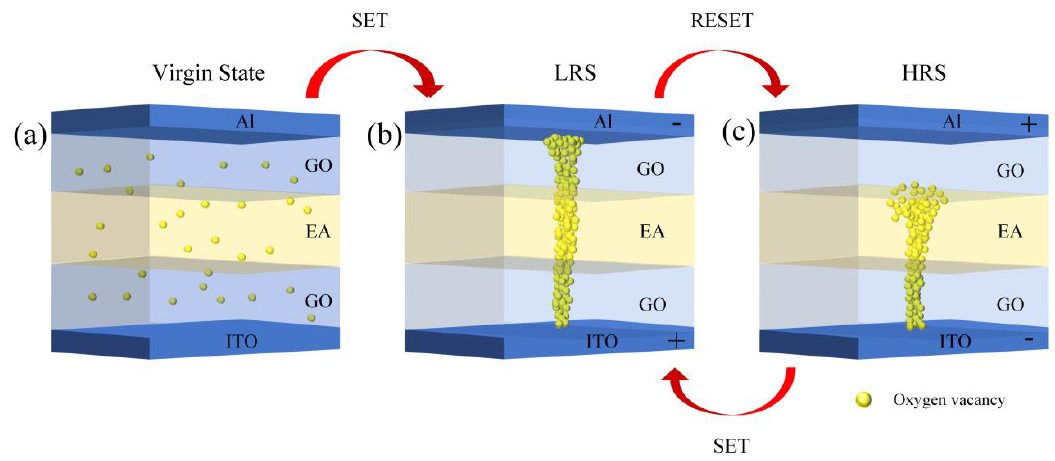
Figure 16. Model of the resistance switching mechanism.